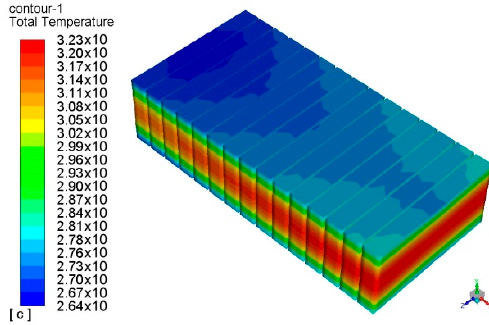
Figure 12. Temperature distribution on battery surface.